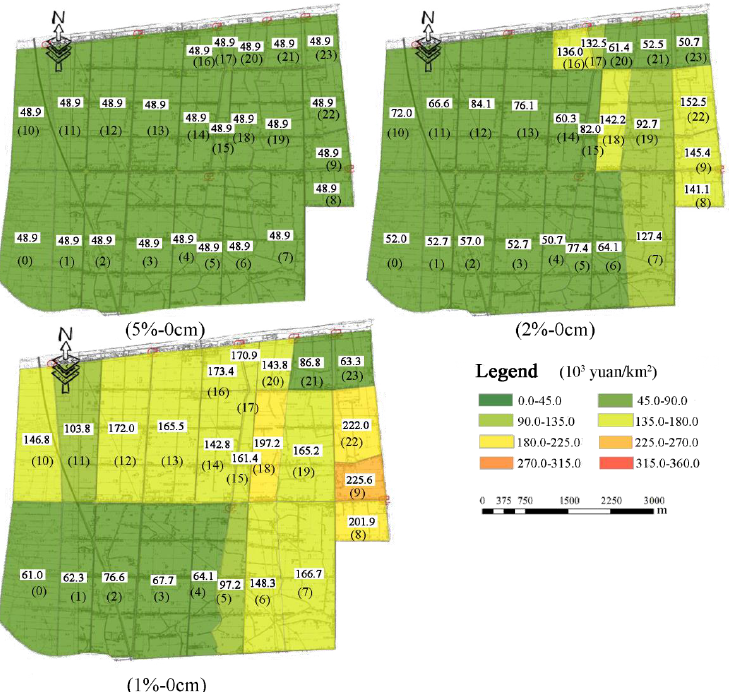
Figure 10. Waterlogging loss of paddy fields with an initial storage depth of 0 cm under different rainfall frequencies.